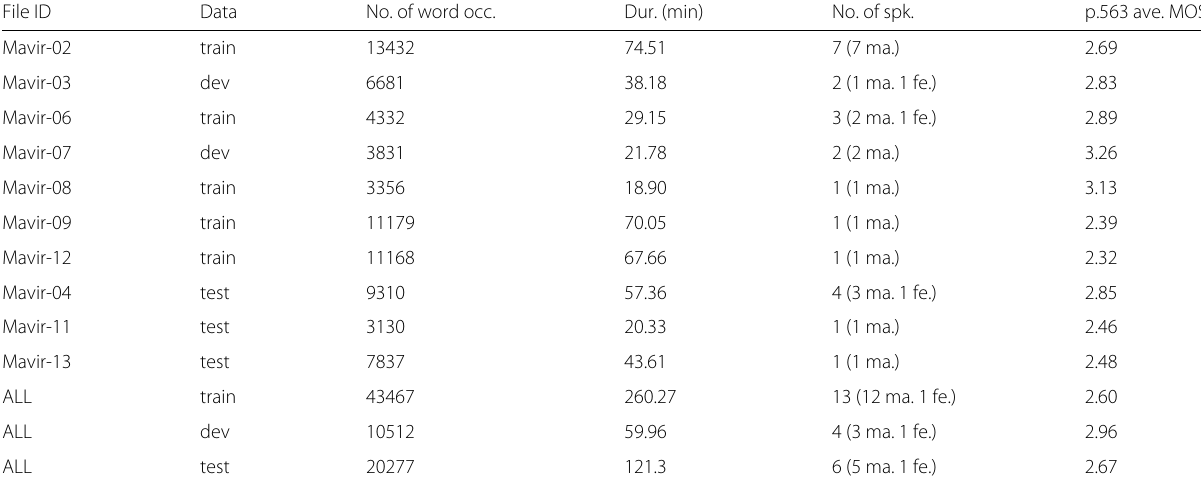
Table 1 Summary of MAVIR